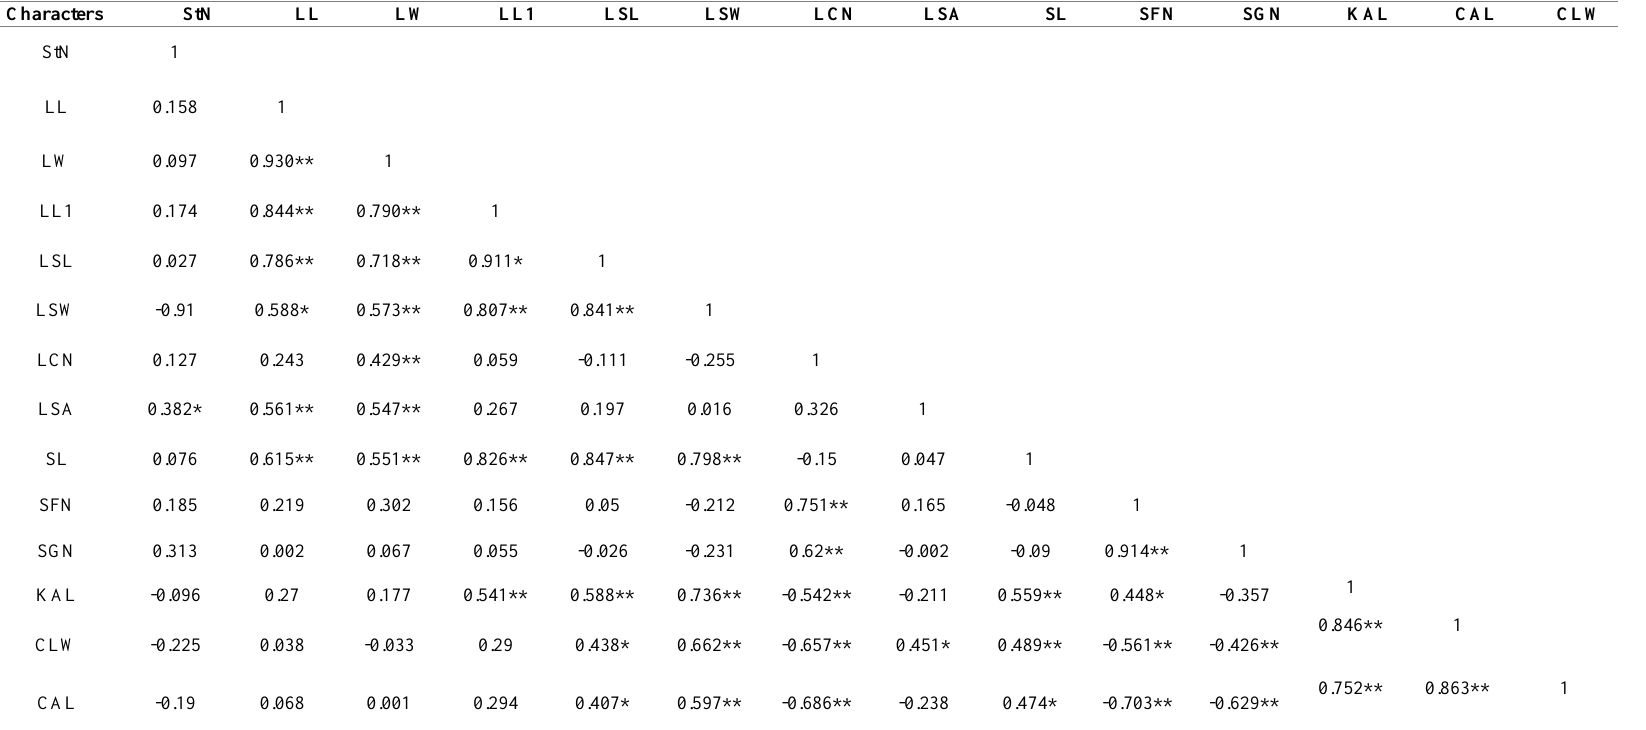
Table 6. The correlation coefficient among some studied features.